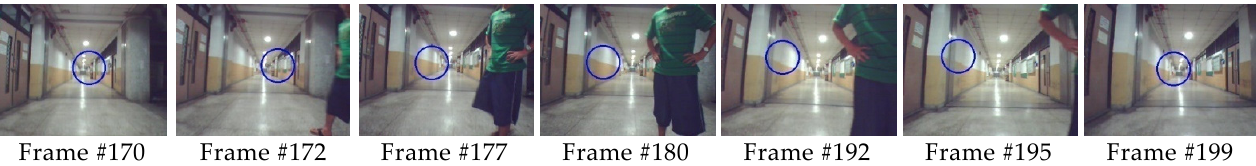
Figure 12. Moving obstacle avoidance of the MUAV. The image sequence is recorded from the camera on the MUAV.